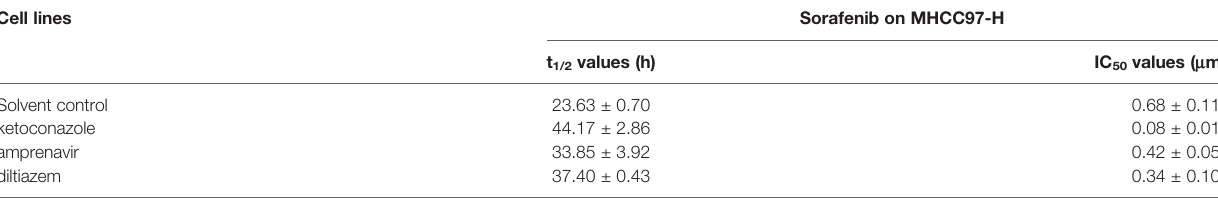
TABLE 6 | The effect of potential inhibitors of CYP3A4 on sorafenib in MHCC97-H cells. Cell